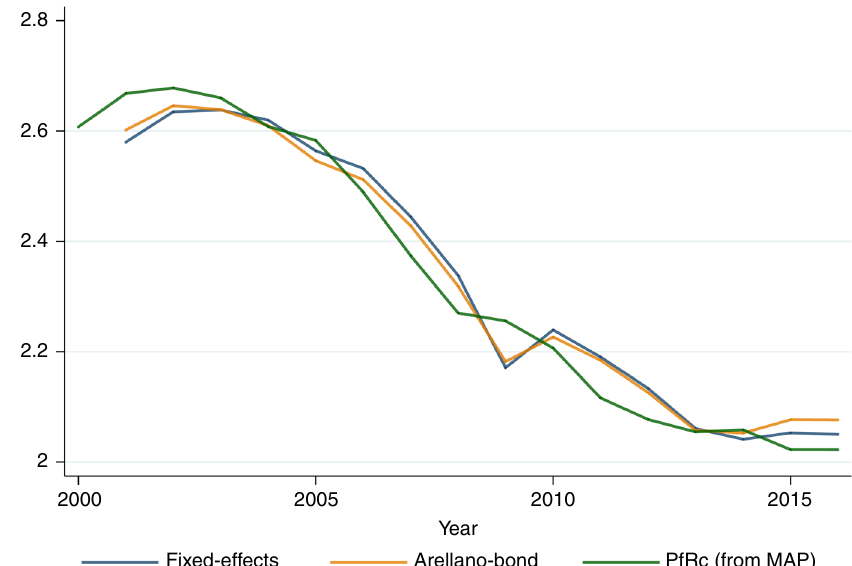
Fig. 1 PfRc (geometric mean from the Malaria Atlas Project-MAP) and predicted PfRc (geometric mean from authors' predictions). The fi gure provides a static simulation of the model, as a simpli fi ed prediction of PfRc compared to the true values of PfRc provided by the Malaria Atlas Project. The blue line provides estimates from a standard fi xed-effects model (within country). The orange line provides estimates from the Arellano − Bond model. The green line provides the Malaria Atlas Project